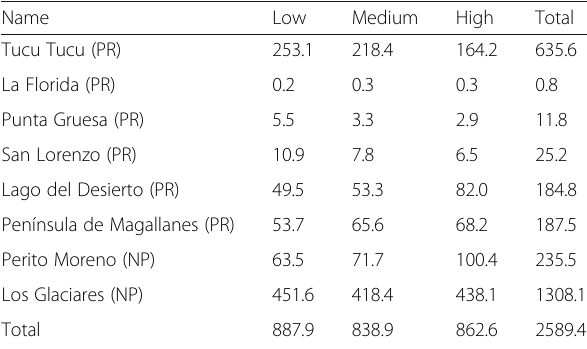
Table 6 Areas (km 2 ) of potential habitat suitability map of huemul classified according to their occurrence inside each Provincial natural reserves (PR) and National Parks (NP), where low is 40 – 50%, medium is 50 – 70%, and high is 70 –